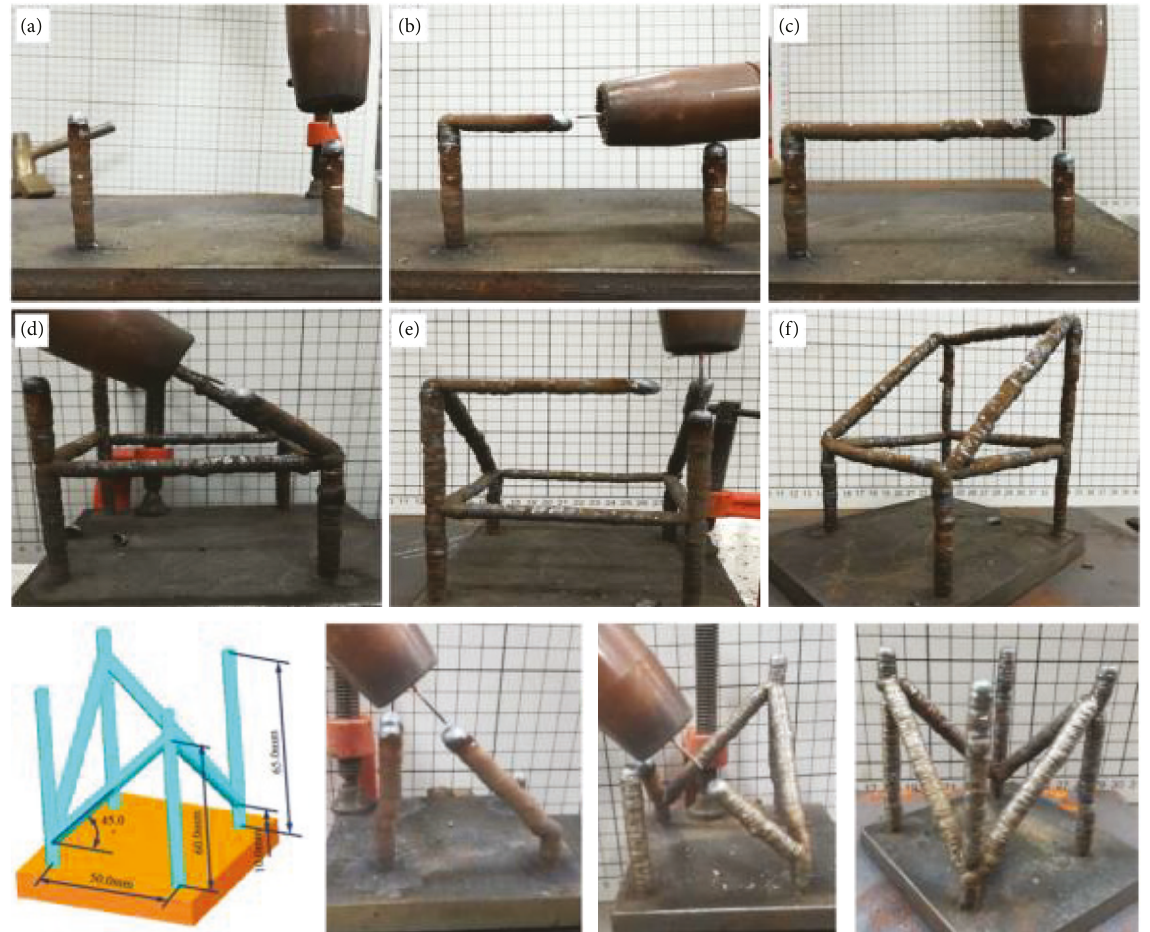
Figure 31: WAAM process of chair truss structure and the stability-enhancing